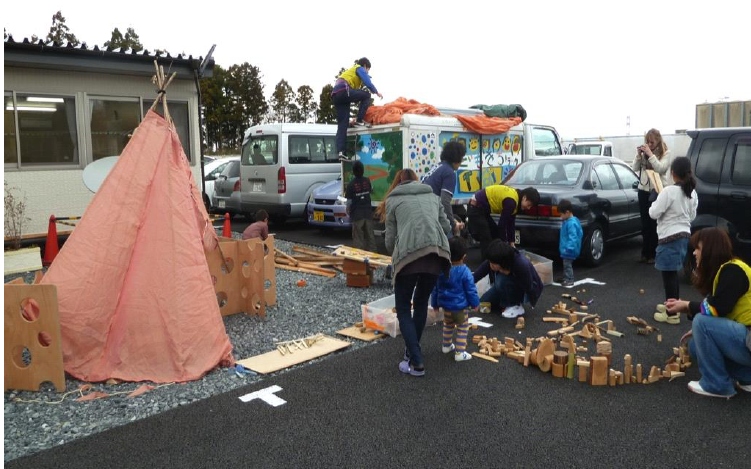
Figure 3. Mobile play truck at a temporary housing